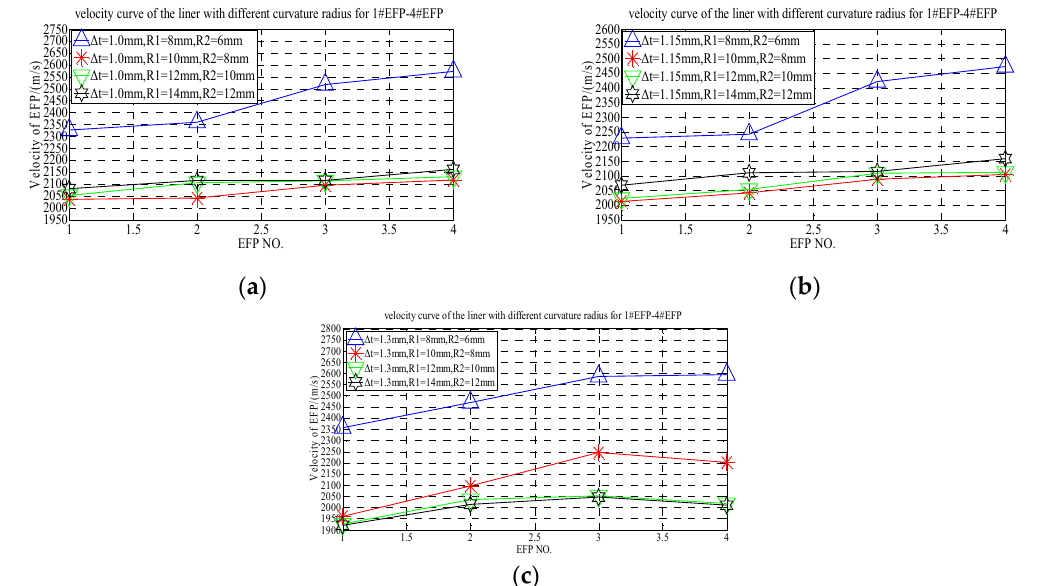
Figure 7. Velocity curve of the liner with different curvature radius for 1#EFP-4#EFP:( a ) The center thickness of liner is 1 mm; ( b ) the center thickness of liner is 1.15 mm; ( c ) the center thickness of liner is 1.3 mm.